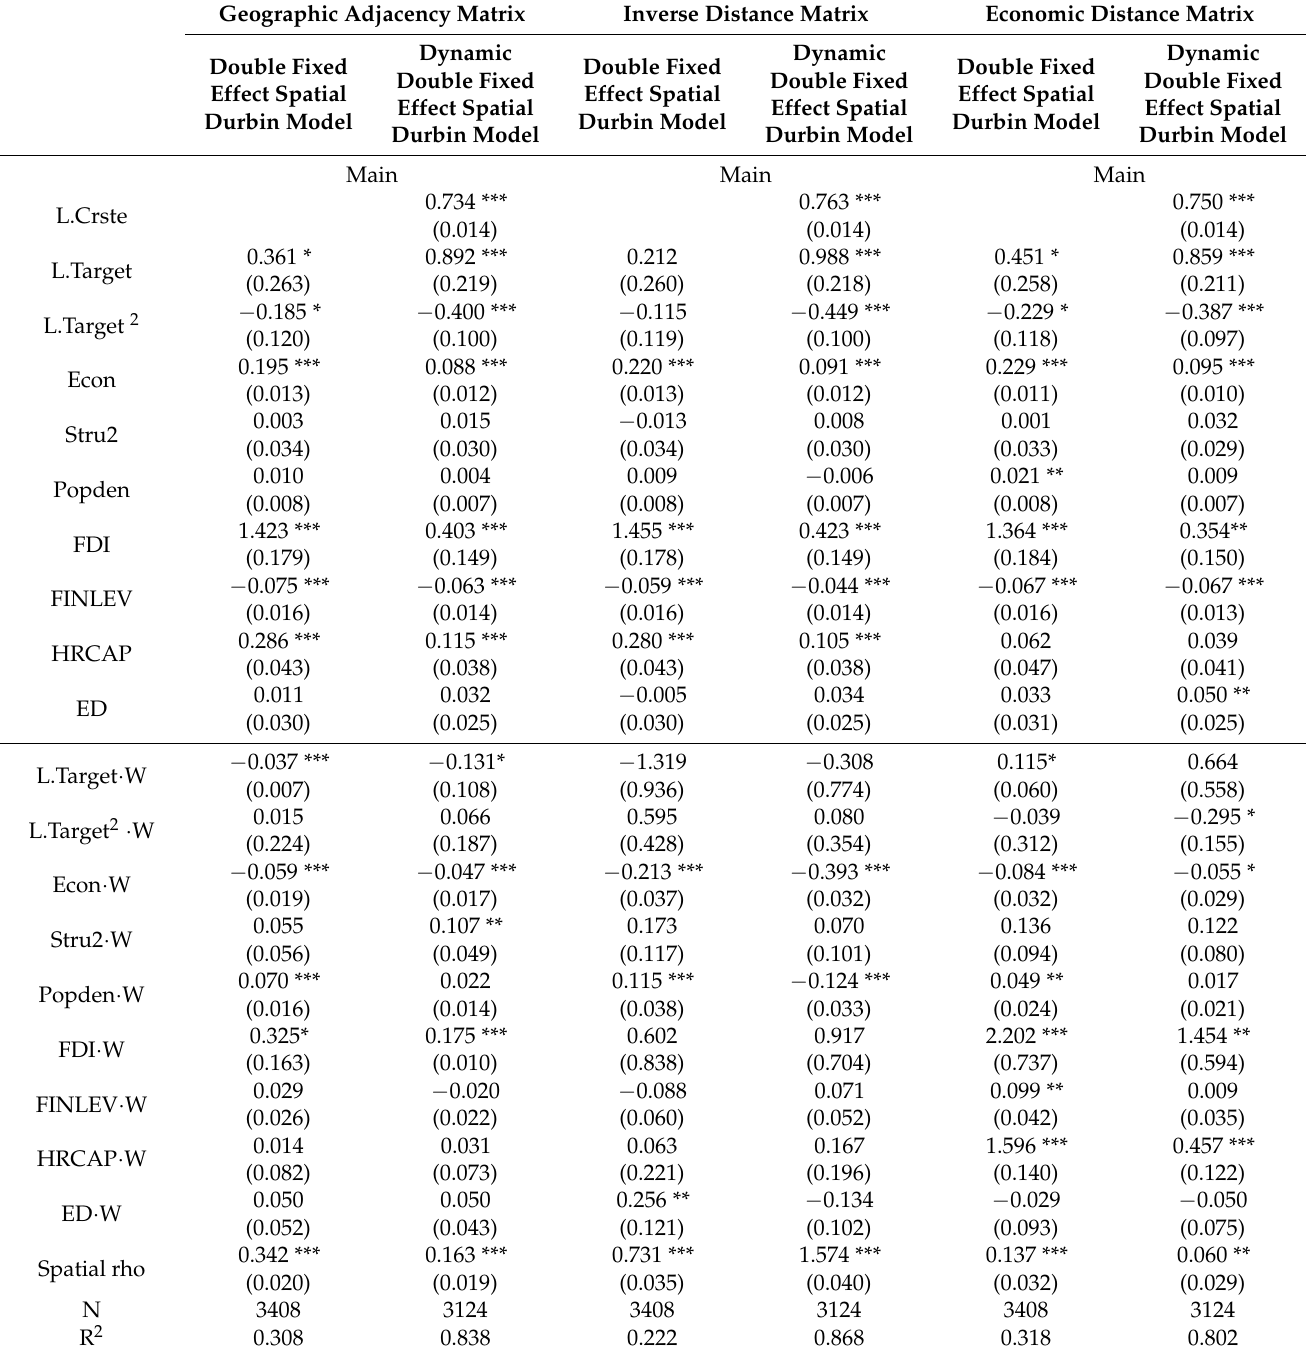
Table 5. Benchmark